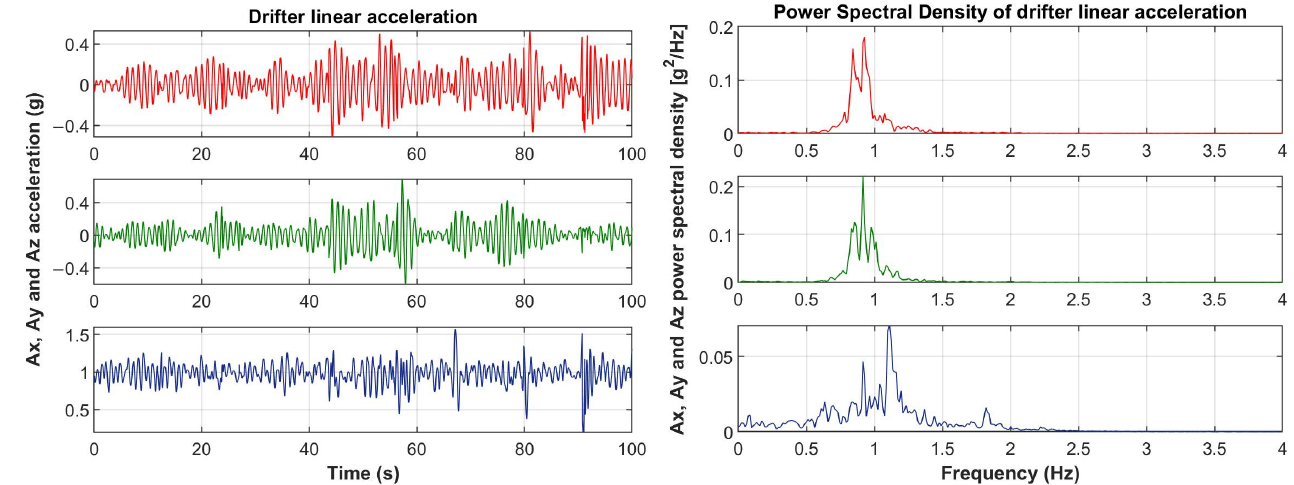
Figure 9. Experimental results of the first test at the sea. ( Left ) time series of the horizontal ( A X : red and A Y : green) and vertical ( A Z : blue) accelerations of the drifter measured at the center of masses. ( Right ) power spectral densities of the linear accelerations.